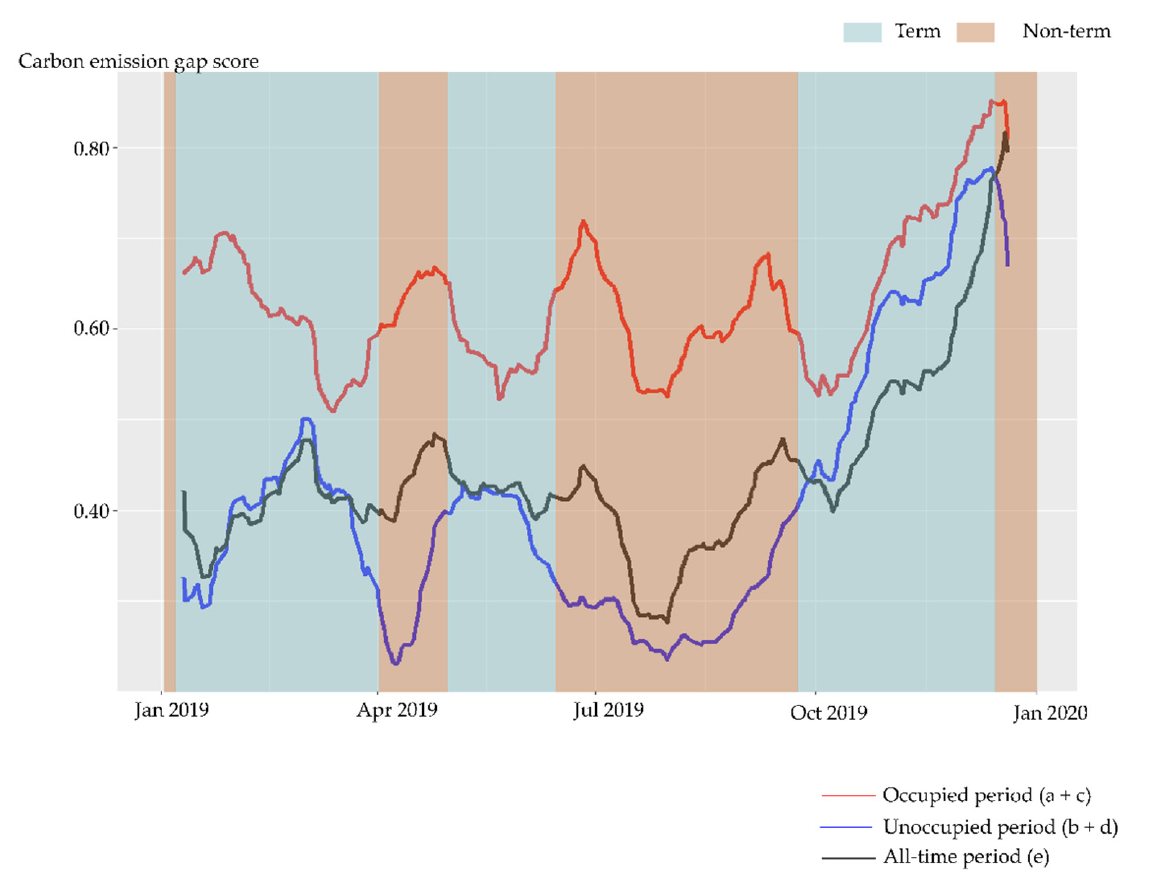
Figure 6. The 15-day rolling average of the carbon emission gap score.